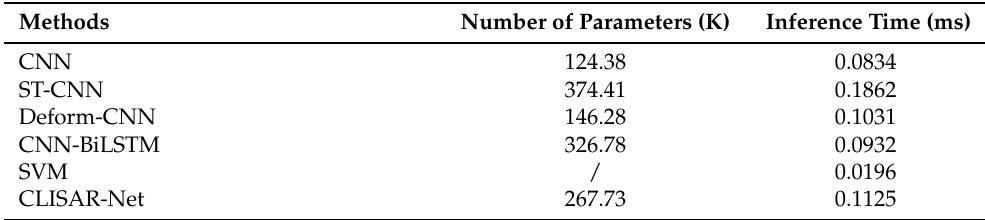
Table 5. Comparisons of the number of trainable parameters and inference time between CLISAR-Net and existing